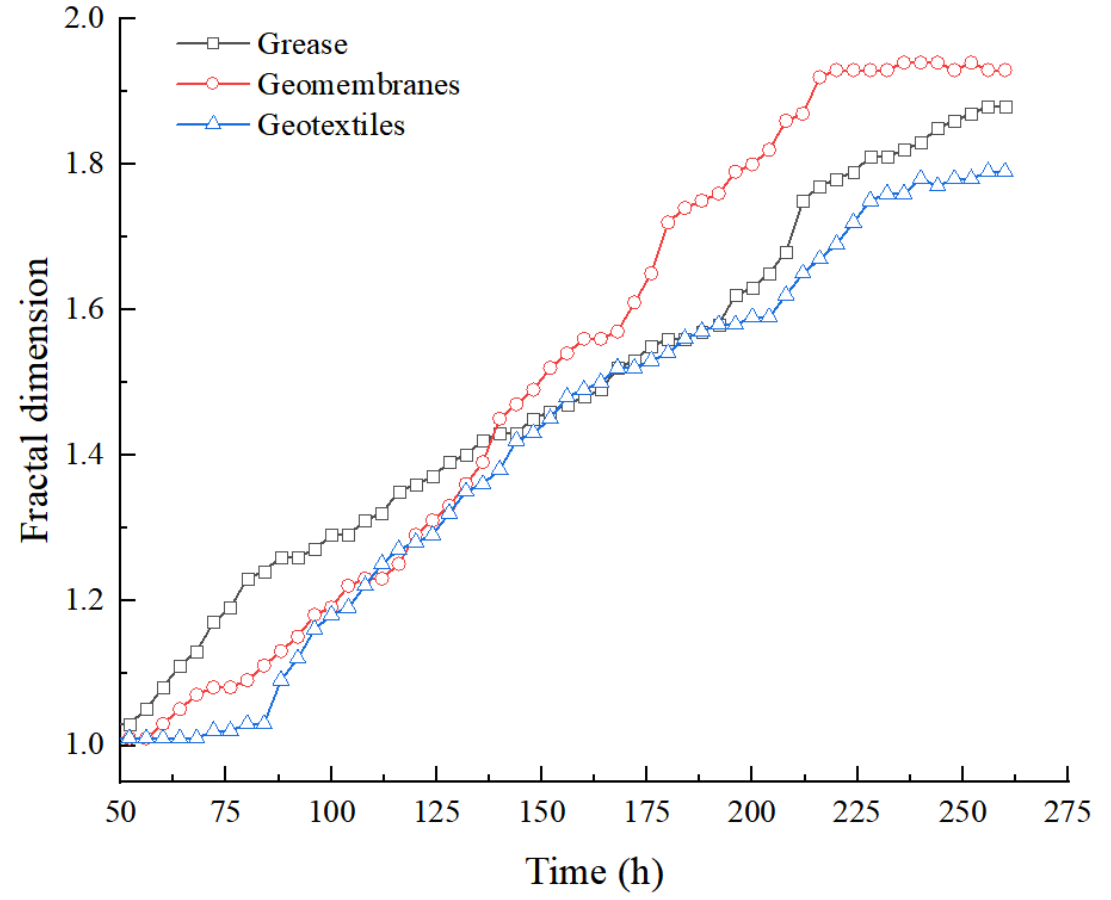
Figure 3. Fractal dimensions of soil samples with grease, geomembranes, and geotextiles over time. Figure 4 shows the variation in the crack intensity factor (CIF) with evaporation dura- tion during the development of surface cracks of samples under different test conditions. The crack intensity factors of samples with grease placed at the bottom were always greater than those of samples with geomembranes and geotextiles placed at the bottom throughout the development of fractures. Additionally, in the final state, the CIF of the sample with grease at the bottom was 2.99% and 4.02% higher than the crack intensity factors of the samples with geomembranes and geotextiles at the bottom, respectively. In the process of fracture development, the crack intensity factor of the sample with grease at the bottom was always the smallest, but after the fracture development stopped, the crack intensity factor was 1.03% higher than that of the sample with geotextiles at the